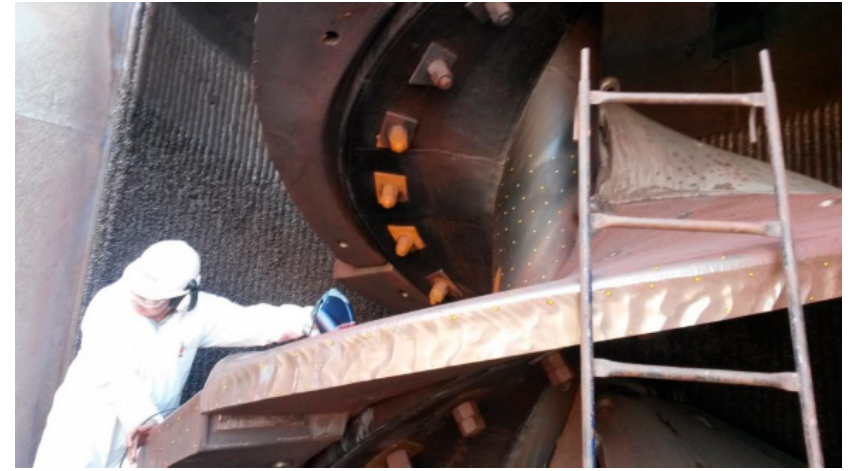
Figure 9. Scanning procedure to obtain a three-dimensional measurement of liner parts [30].